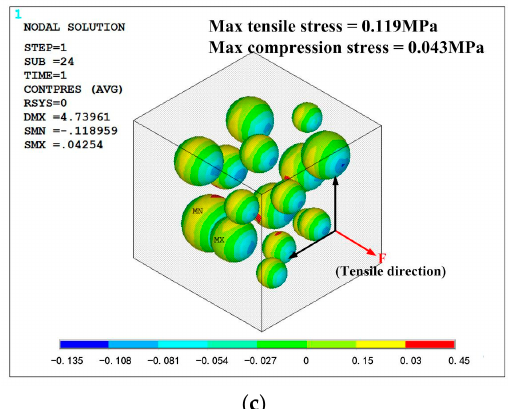
Figure 16. Contact stress between particles and silicone: ( a ) mass fraction of 10%; ( b ) mass fraction of 20%; ( c ) mass fraction of 40%.